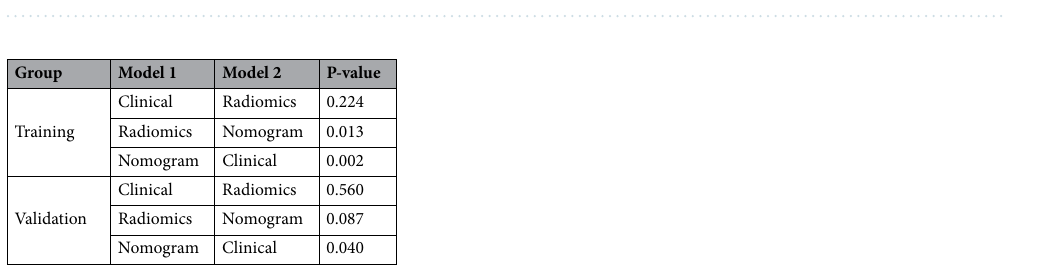
Figure 5. The AUC values for radiomic signatures used in identifying benign and malignant ovarian tumors. (left: training set; middle: test set; right: external set).